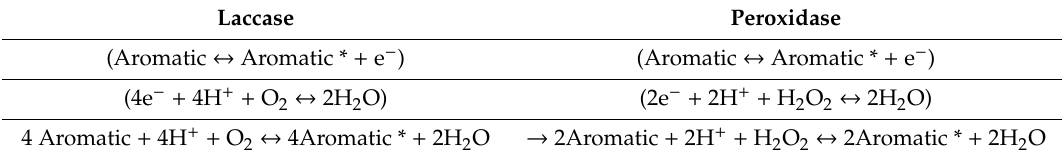
Table 3. Brief comparison of laccase / peroxidase-substrate oxidation per catalytic cycle.